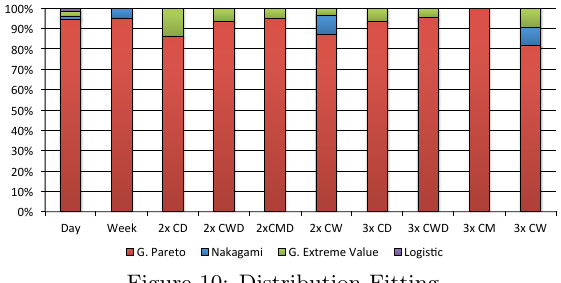
Figure 10: Distribution